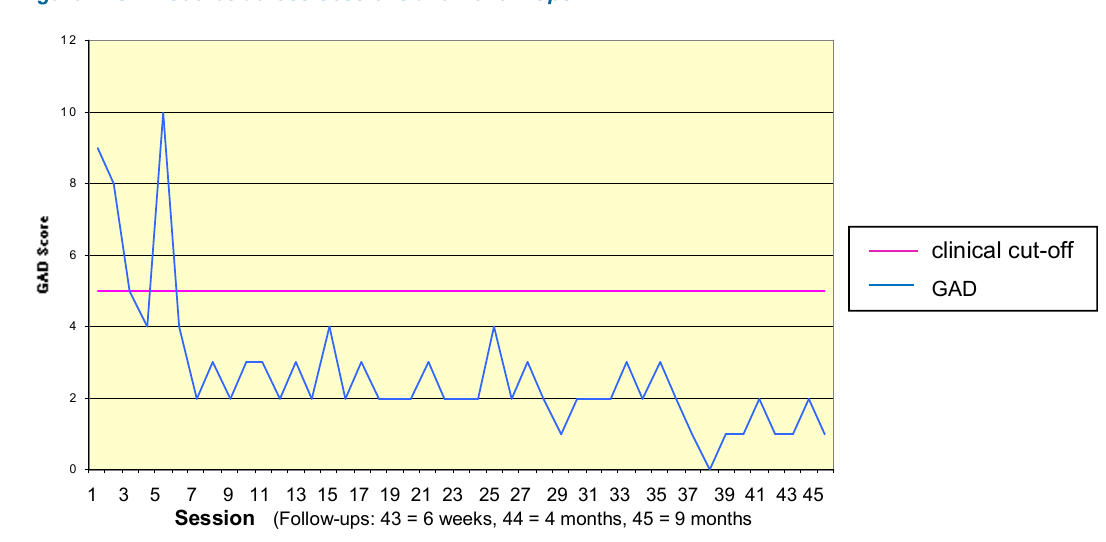
Figure 2: GAD Scores across Sessions and